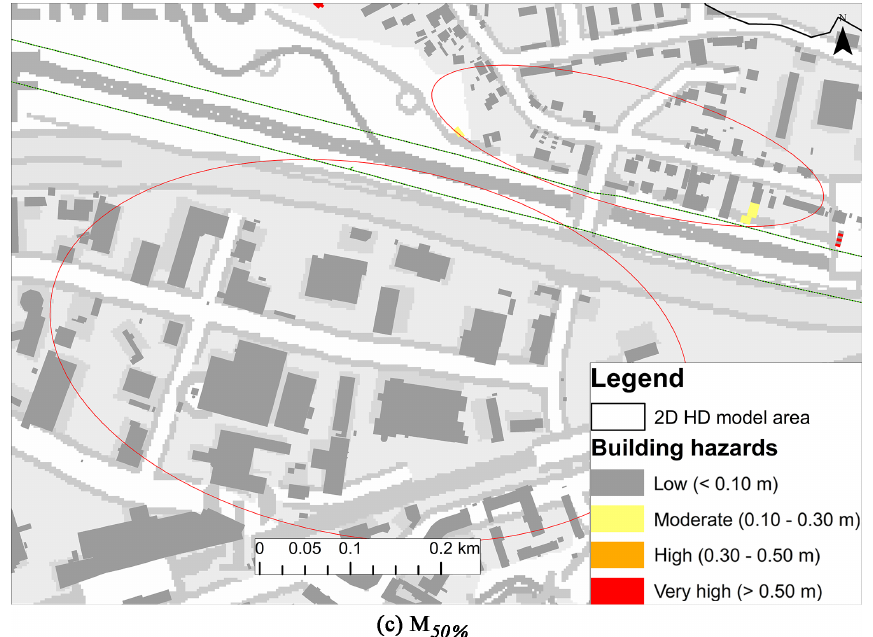
Figure 9. Comparison of building hazard maps between best model ( M 50% ) vs. multi-model combinations. The areas with prominent change are highlighted in red circles. (Data source: Geobasisdaten © Bayerische Vermessungsverwaltung, http://www.geodaten.bayern.de, last access: 5 March